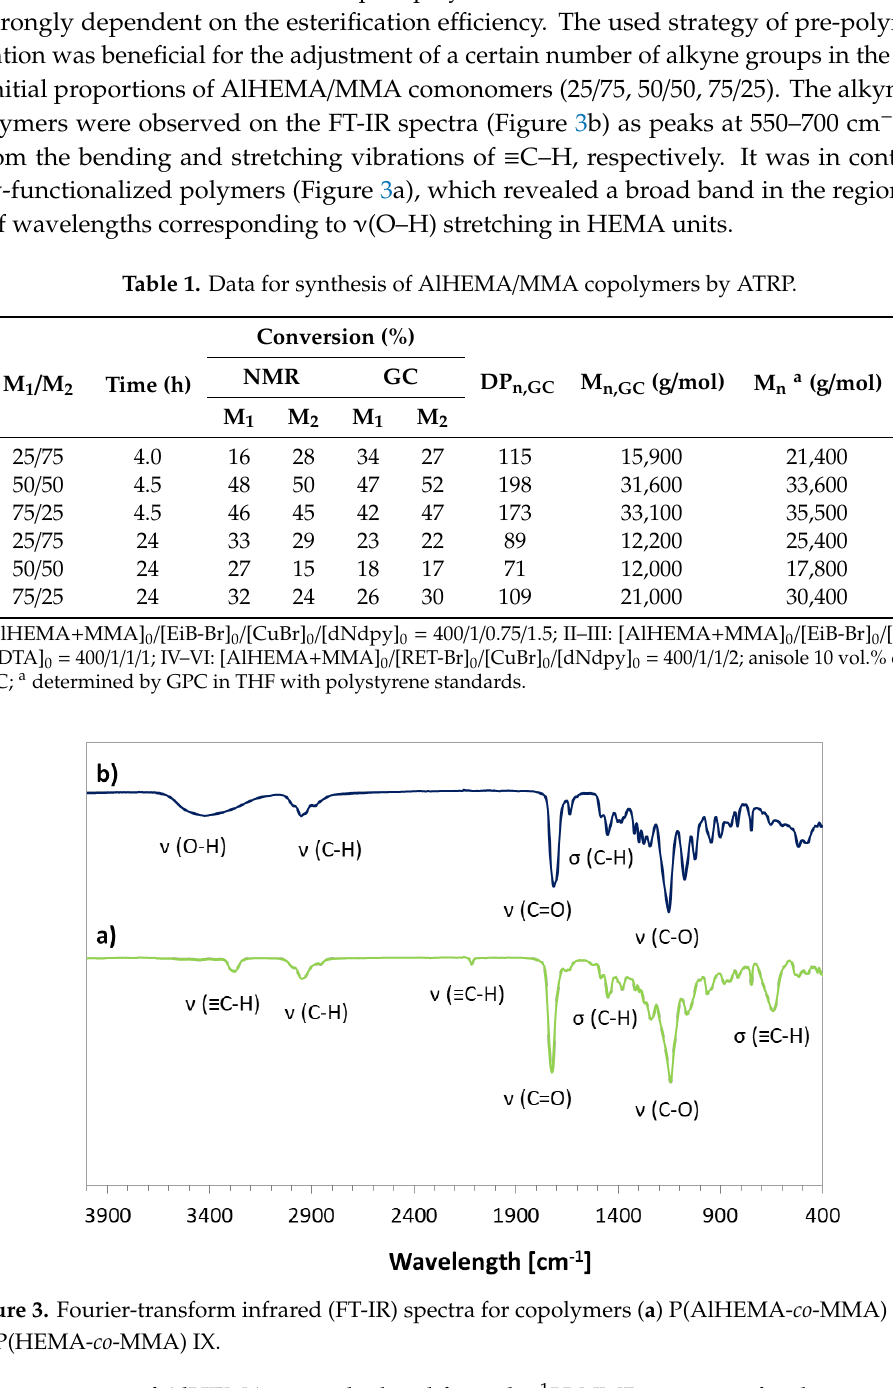
Figure 3. Fourier-transform infrared (FT-IR) spectra for copolymers ( a ) P(AlHEMA- co -MMA) III and ( b ) P(HEMA- co -MMA) IX .